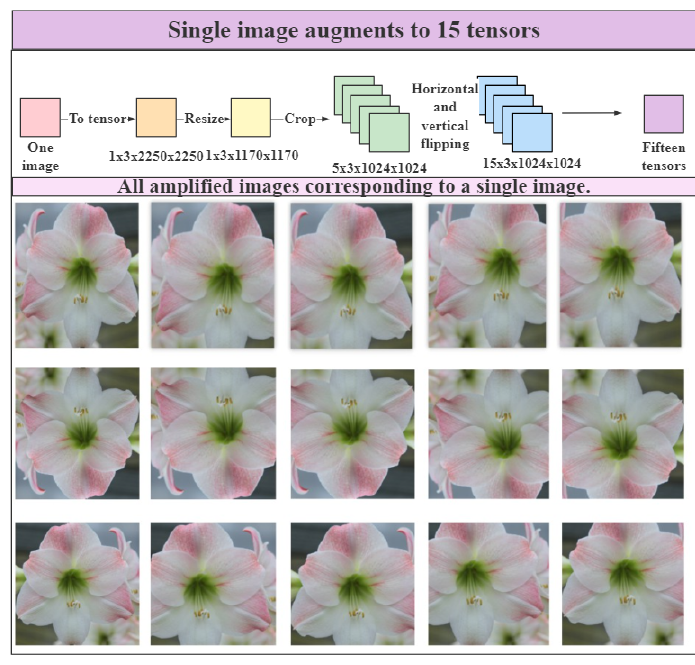
Figure 3. Simple data